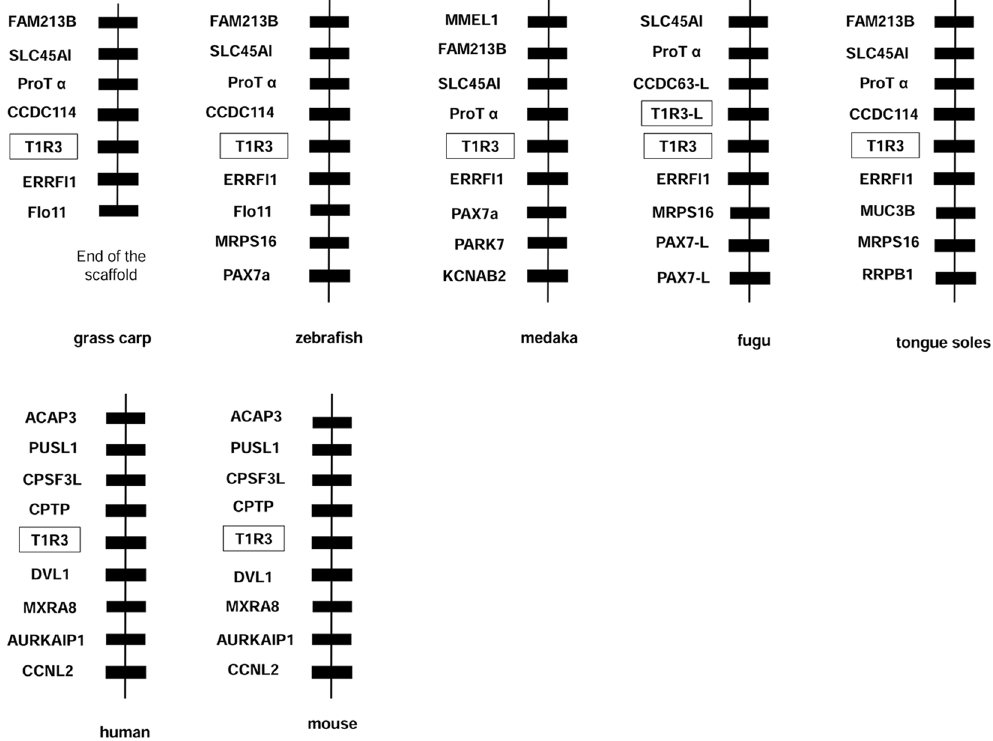
Figure 6. Synteny analyses of T1R3 genes. The adjacent genes of T1R3 were partially conserved. The solute carrier family 45 member 1 (SLC45A1), prothymosin alpha-like (ProT α ), coiled-coil domain containing 114 (CCDC114) genes located upstream of T1R3 in most fishes. The ERBB receptor feedback inhibitor 1 (ERRFI1) was always next to the T1R3 gene in fish. Mitochondrial ribosomal protein S16 (MRPS16) and paired box 7a (PAX7a) genes are frequently downstream of fish